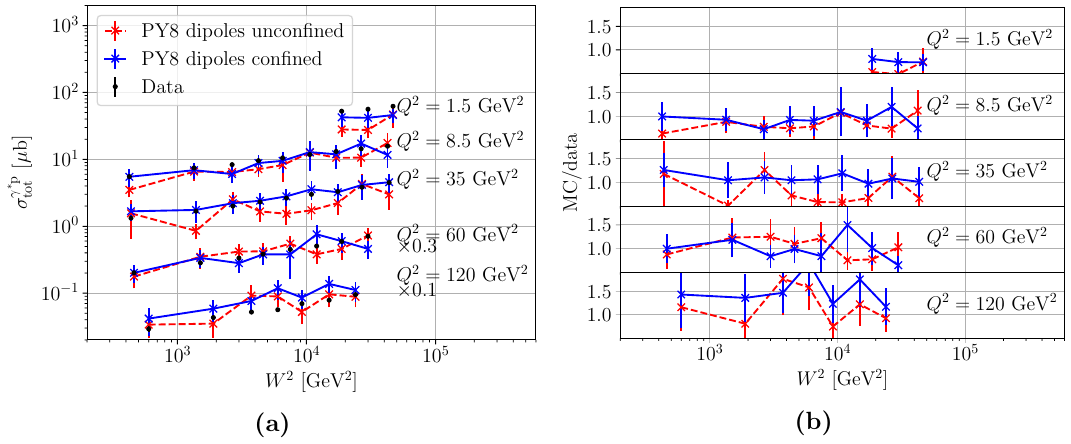
Figure 7. The total photon-proton cross section, (cid:27) (cid:13) (cid:3) p , as a function of squared photon-proton tot center-of-mass energy, W 2 , for several virtualities (a). Note that the distributions for the two highest virtualities ( Q 2 = 60 ; 120 GeV 2 ) have been scaled with a factor of 0 : 3 ; 0 : 1, respectively, for better visibility. (b) shows the ratio MC/data as a function of squared center-of-mass energy, W 2 , for the (cid:12)ve di(cid:11)erent